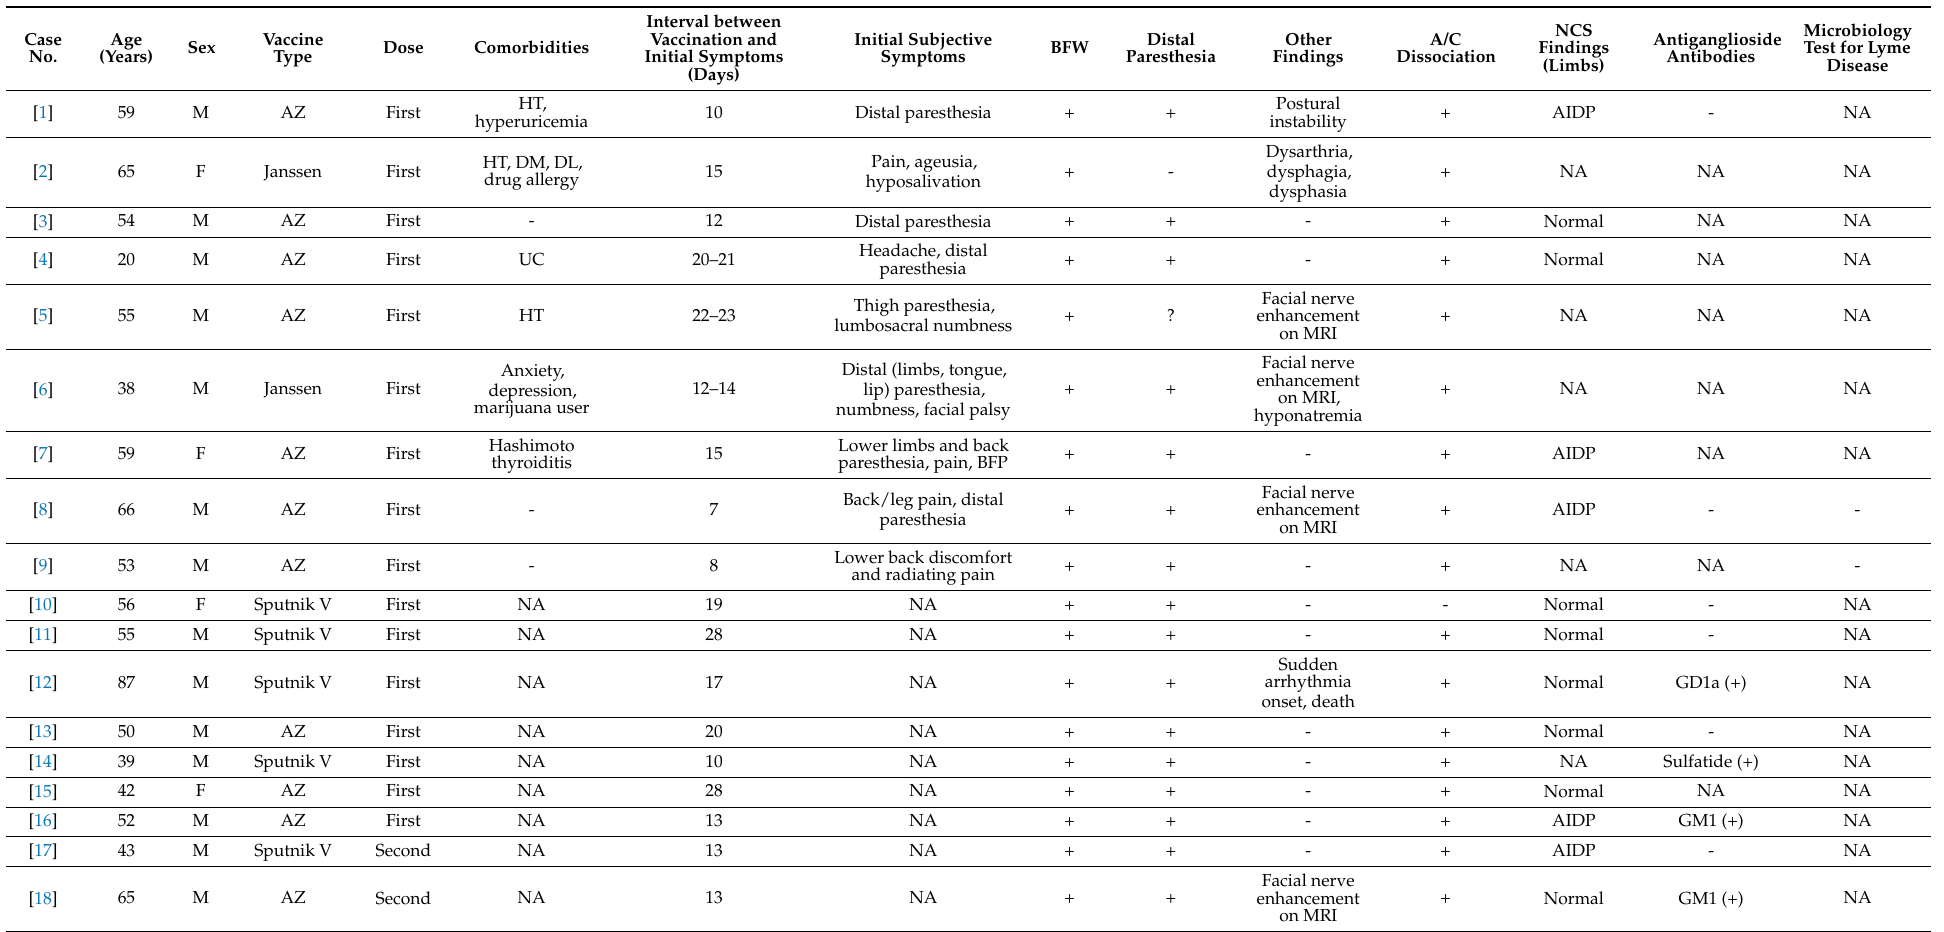
Table 2. Demographic, clinical, and laboratory characteristics of patients with bilateral facial weakness with distal paresthesia following COVID-19 vaccination. Case